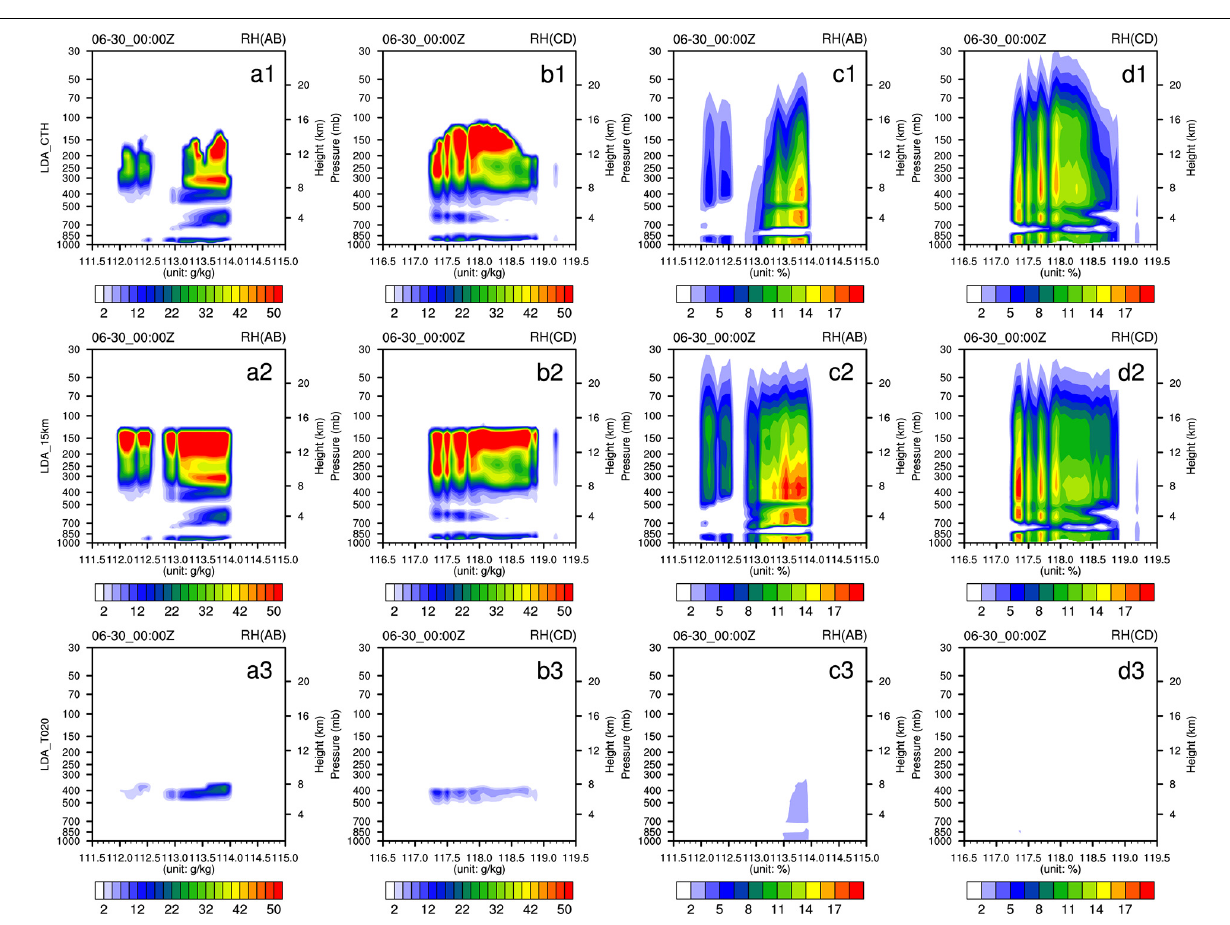
FIGURE 5 | Vertical cross sections of the relative humidity (RH) for the pseudo-observation minus the background (a1–a3,b1–b3) and the analysis increments (c1–c3,d1–d3) along lines AB and CD in Figure 4 a1 for 0000 UTC on 30 June 2018. The first row shows LDA_CTH, the second row shows LDA_15km, and the third row shows LDA_T020. The first and third columns show cross section AB, and the second and fourth columns show cross section